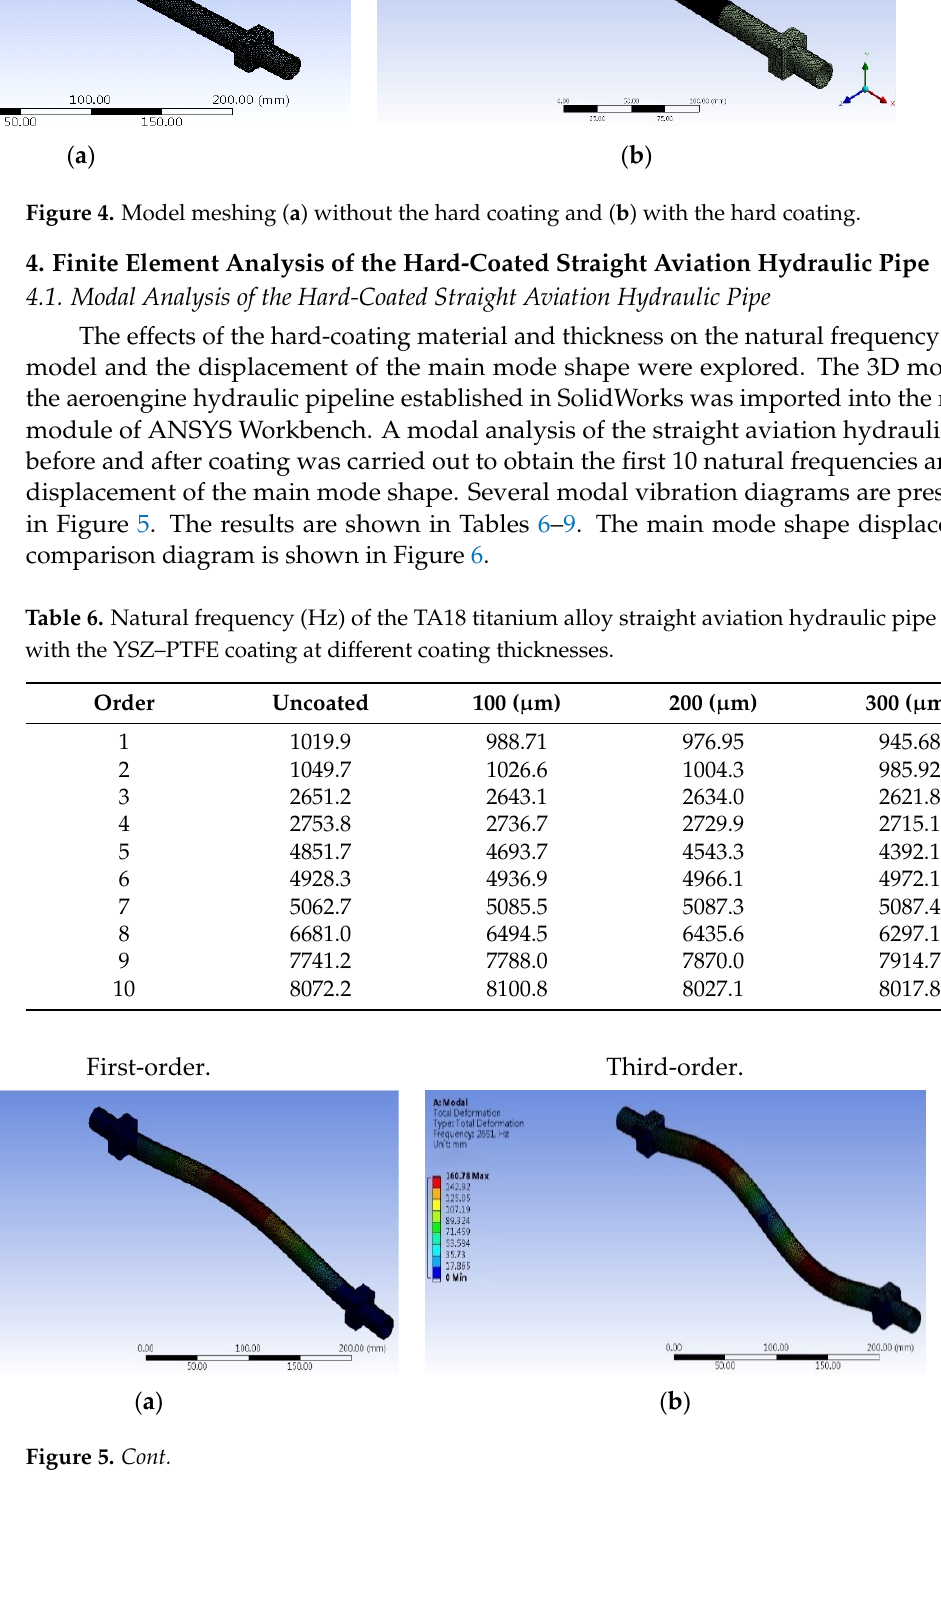
Figure 3. Grid classification.